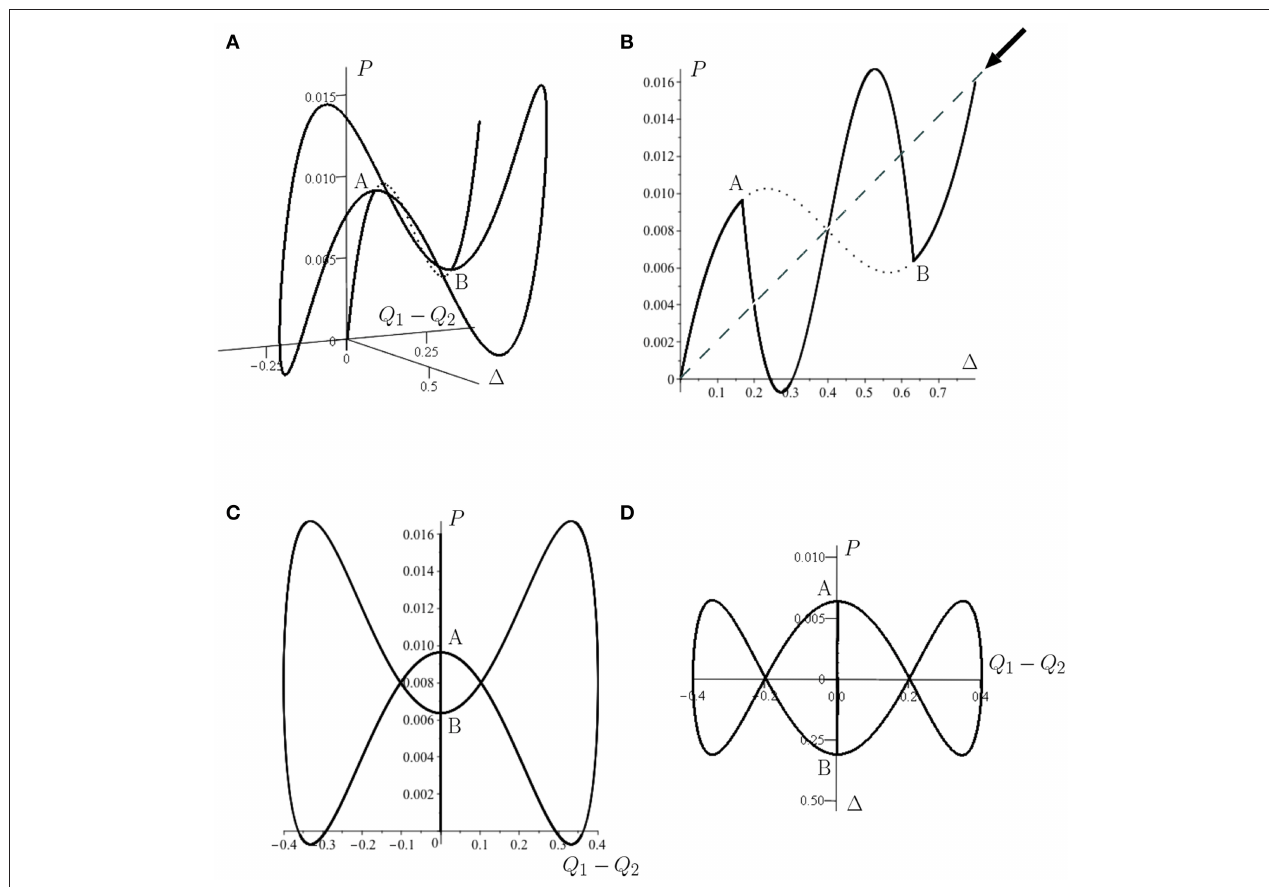
FIGURE 23 | Response of the cell of Figure 22 for L dotted line unstable states. (A) Three-dimensional plot of load P against its corresponding deflection 1 Q 2 ). (B) Projection onto the P ( Q 1 −